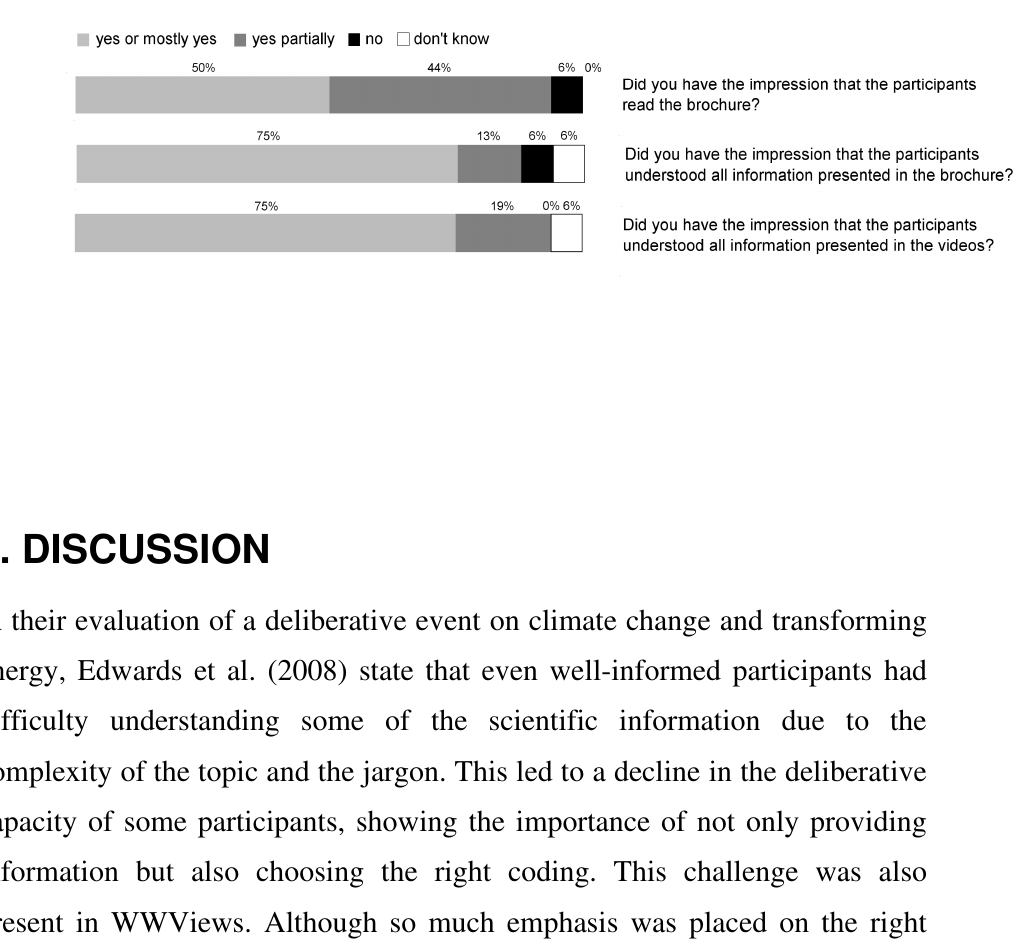
Figure 8. WWViews facilitators’ assessment of participants’ level